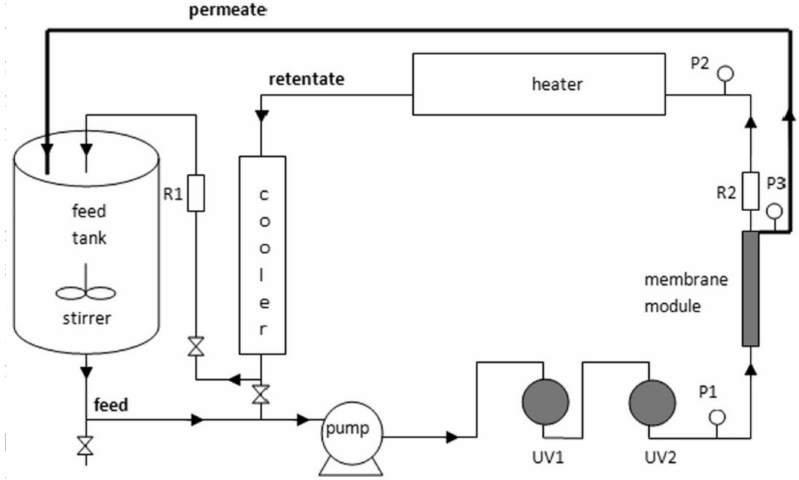
Figure 13. Schematic diagram of the laboratory scale PMR with ceramic membranes used for HA removal from water